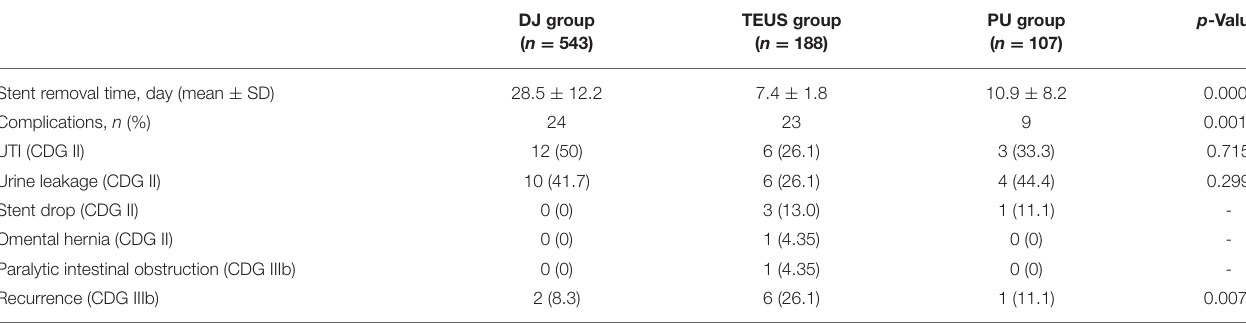
TABLE 2 | The three drainage stents’ removal time and